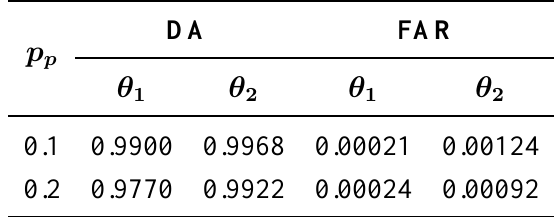
Table 4. DA and FAR for two different threshold values θ and l = 2 r